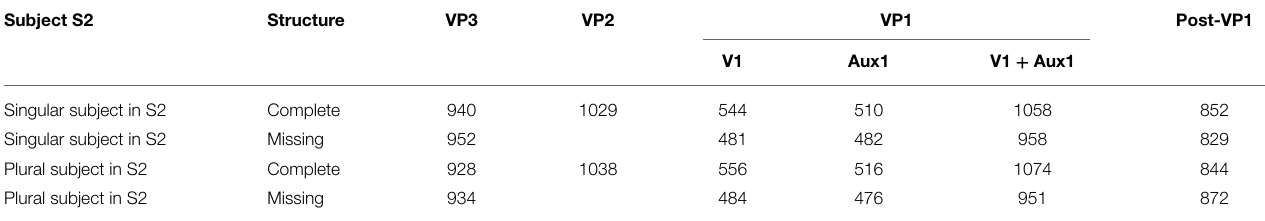
TABLE 3 | Mean reading times in experiment 2.